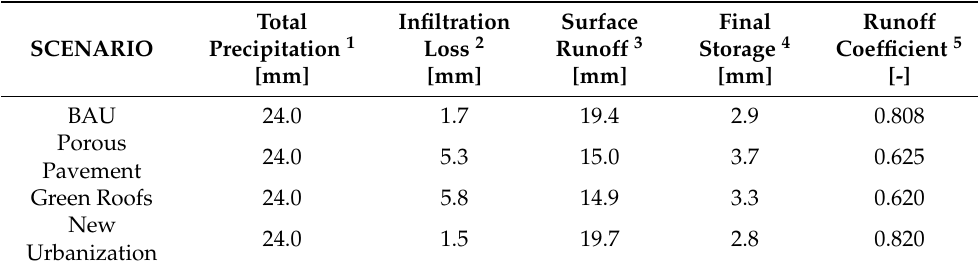
Figure 10. Comparison between “BAU” and “green roof” scenarios. Table 1. Simulation results for each potential